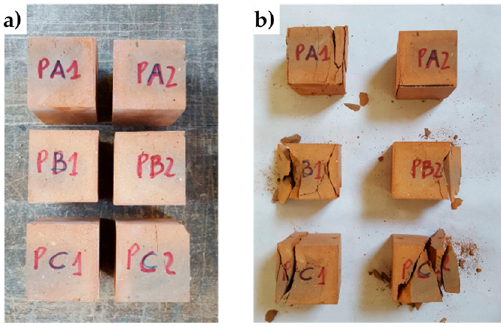
Figure 31. The six specimens tested for brick characterization: ( a ) before the test, ( b ) after the test. Table 1. Geometric and mechanical characteristics of the six brick specimens.